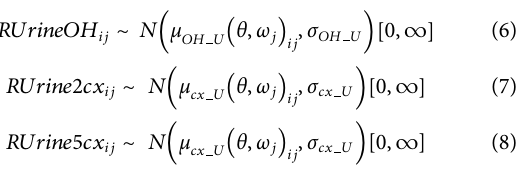
TABLE 4 Global prior and posterior distributions. Parameter Median (95% interval) Prior